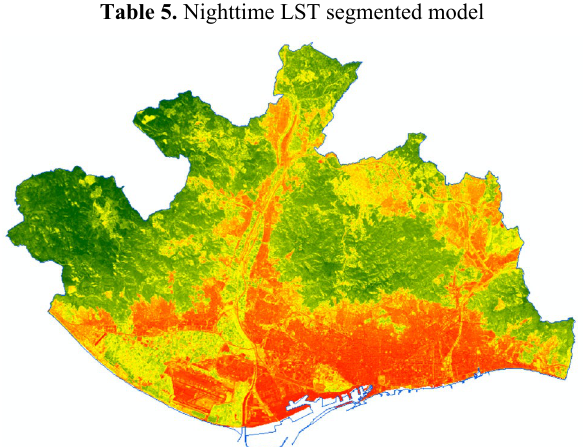
Figure 11. Nighttime LST (degmented model)